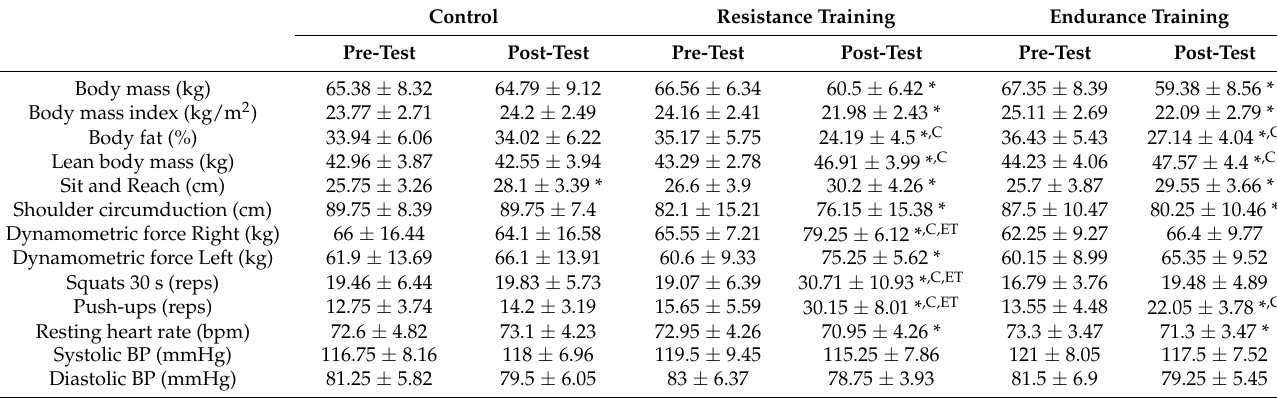
Table 3. Descriptive statistics (data are given as means ± standard deviations), and post hoc differences of the analysis of